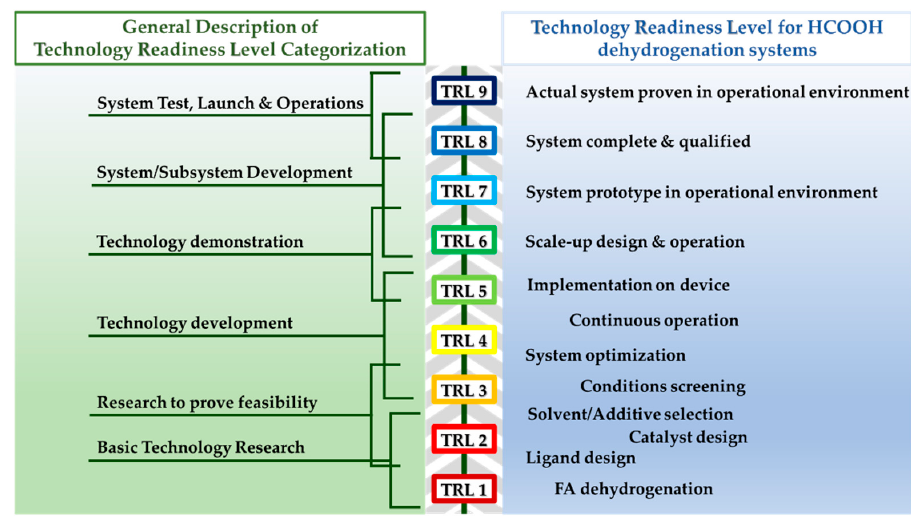
Figure 6. Technology Readiness Levels (TRL) for FA dehydrogenation catalytic systems.